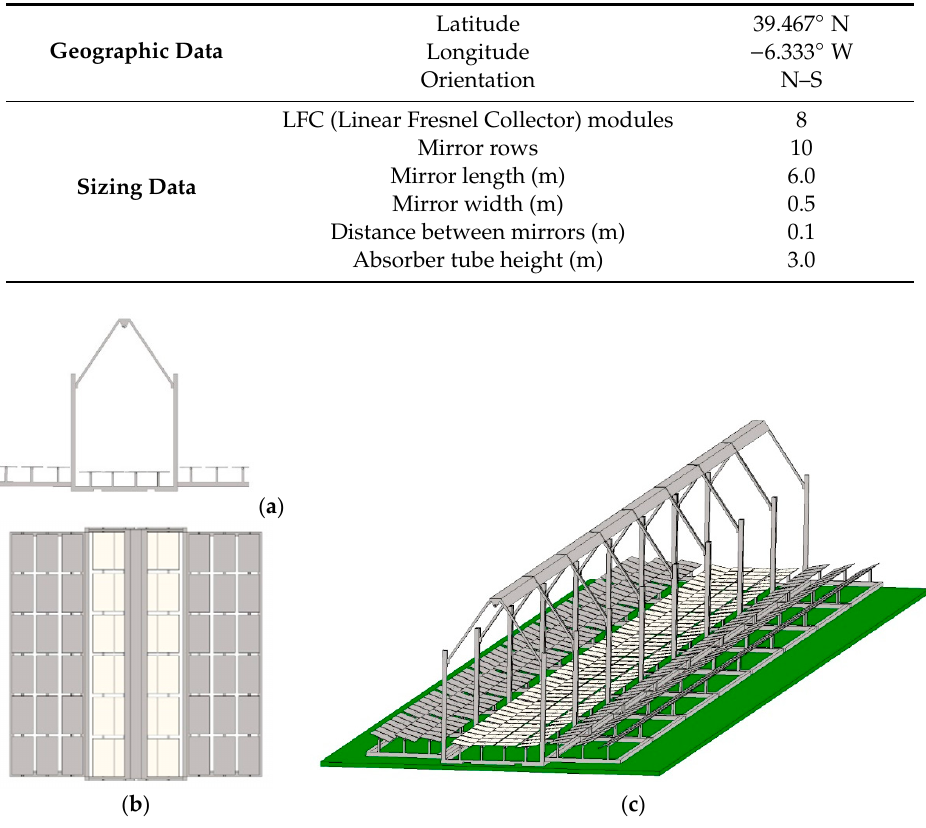
Figure 1. Front ( a ) and top view ( b ) of a module, and 3D diagram of LFC ( c ).